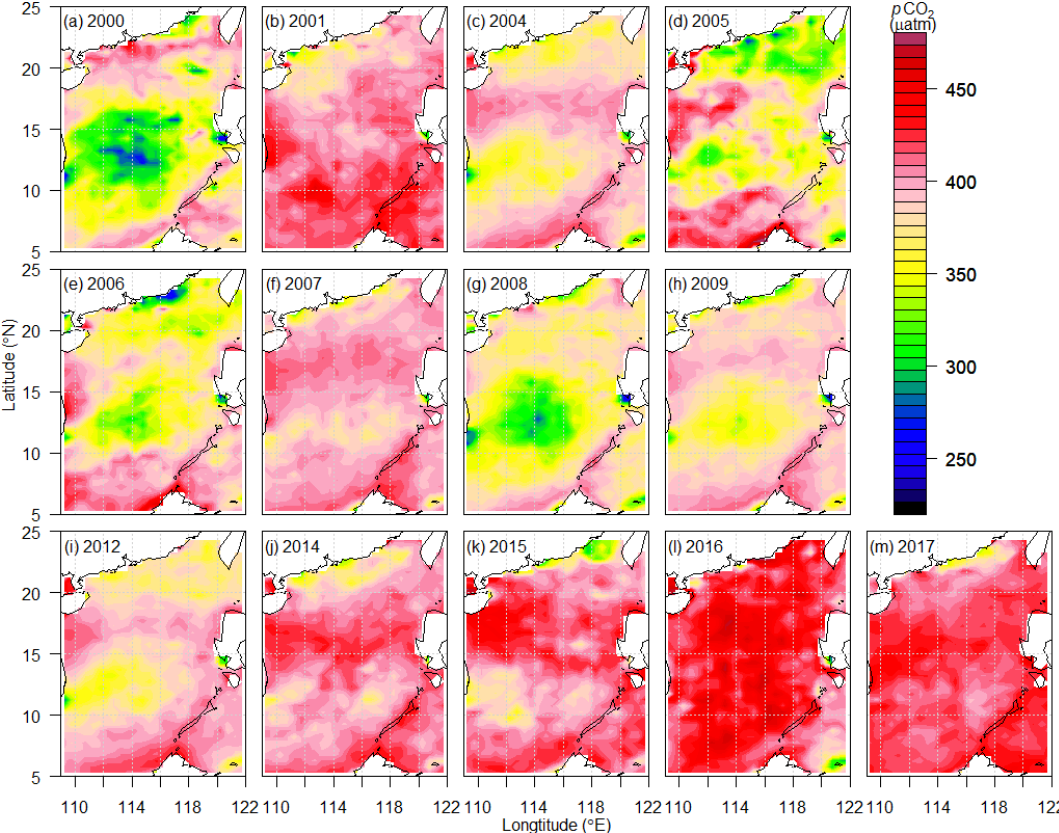
Figure 8. Reconstructed summer p CO 2 fields for the years 2000–2017 in the